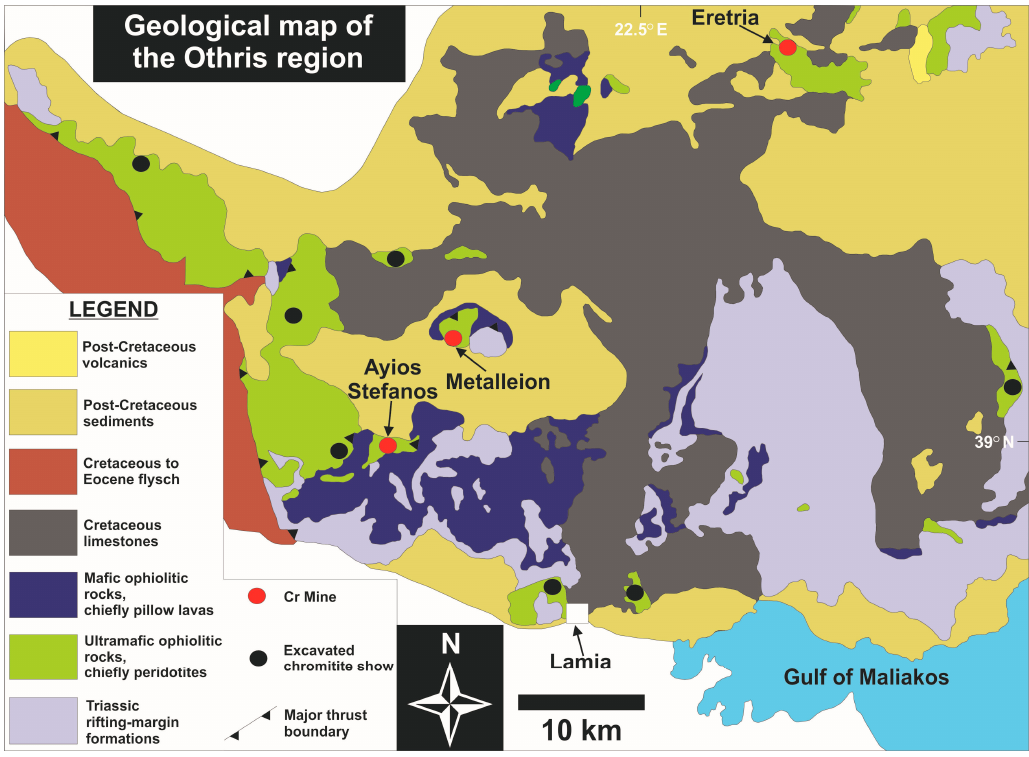
Figure 2. Geological map of the Othris ophiolite complex [33].